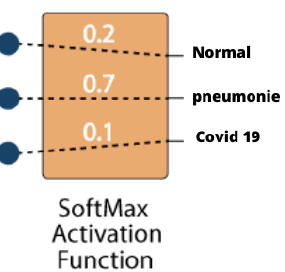
Figure 4. Probabilistic